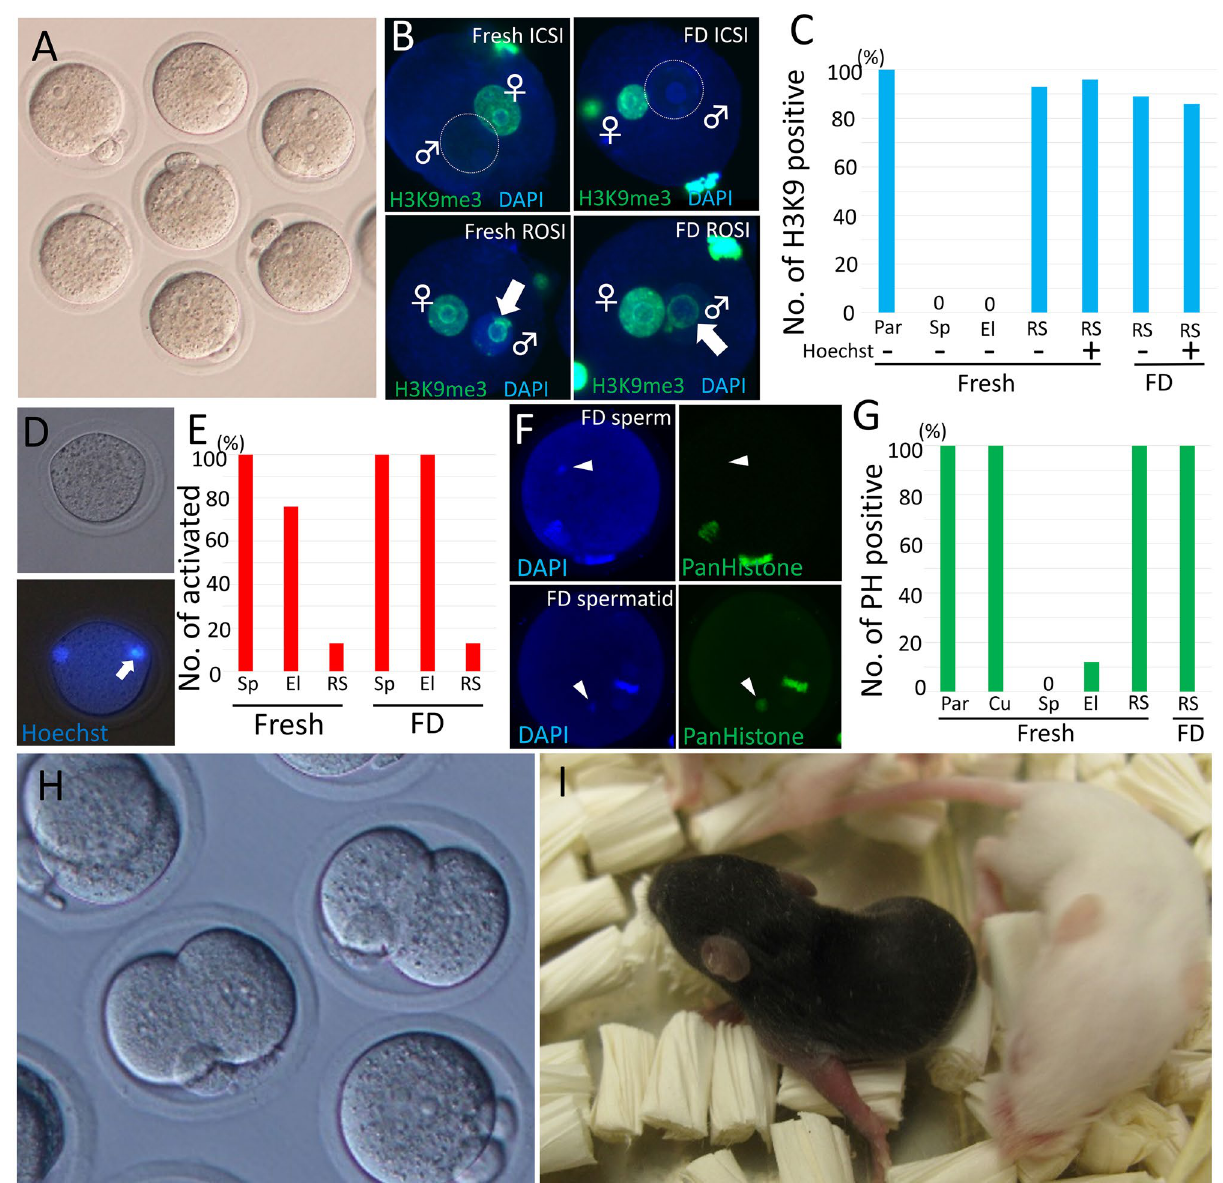
Figure 2. Confirmation of spermatid after injection into oocytes and production of offspring from FD spermatids. ( A ) Six hours after injection and activation, most oocytes formed male and female pronuclei. ( B ) Immunostaining of zygotes derived from fresh sperm (upper left), fresh spermatids (bottom left), FD sperm (upper right), and FD spermatids (bottom right) using the anti-H3K9me3 antibody. The arrow shows the male prenucleolar ring. ( C ) The ratio of H3K9me3 positive zygotes. Par: parthenogenetically activated zygote; Sp: spermatozoa; El: elongated spermatid; RS: round spermatid. The chromocenter of some round spermatids were observed before collection using Hoechst staining and UV light. ( D ) FD spermatids were injected into oocytes without artificial activation. Six hours after injection, these oocytes had pseudo-MII spindles derived from FD spermatid nuclei (upper, bright image; bottom, DNA under UV light). ( E ) The ratio of activated oocytes after germ cell injection. ( F ) Immunostaining of oocytes injected with FD sperm (upper) or FD spermatid (bottom). Left panel showed DNA staining by DAPI, and right panel showed histone staining using the anti-pan-histone antibody. The arrow shows the male pronucleus. ( G ) The ratio of pan-histone (PH) positive zygotes. ( H ) Two- cell stage embryos derived from FD spermatids. ( I ) Offspring were obtained from FD